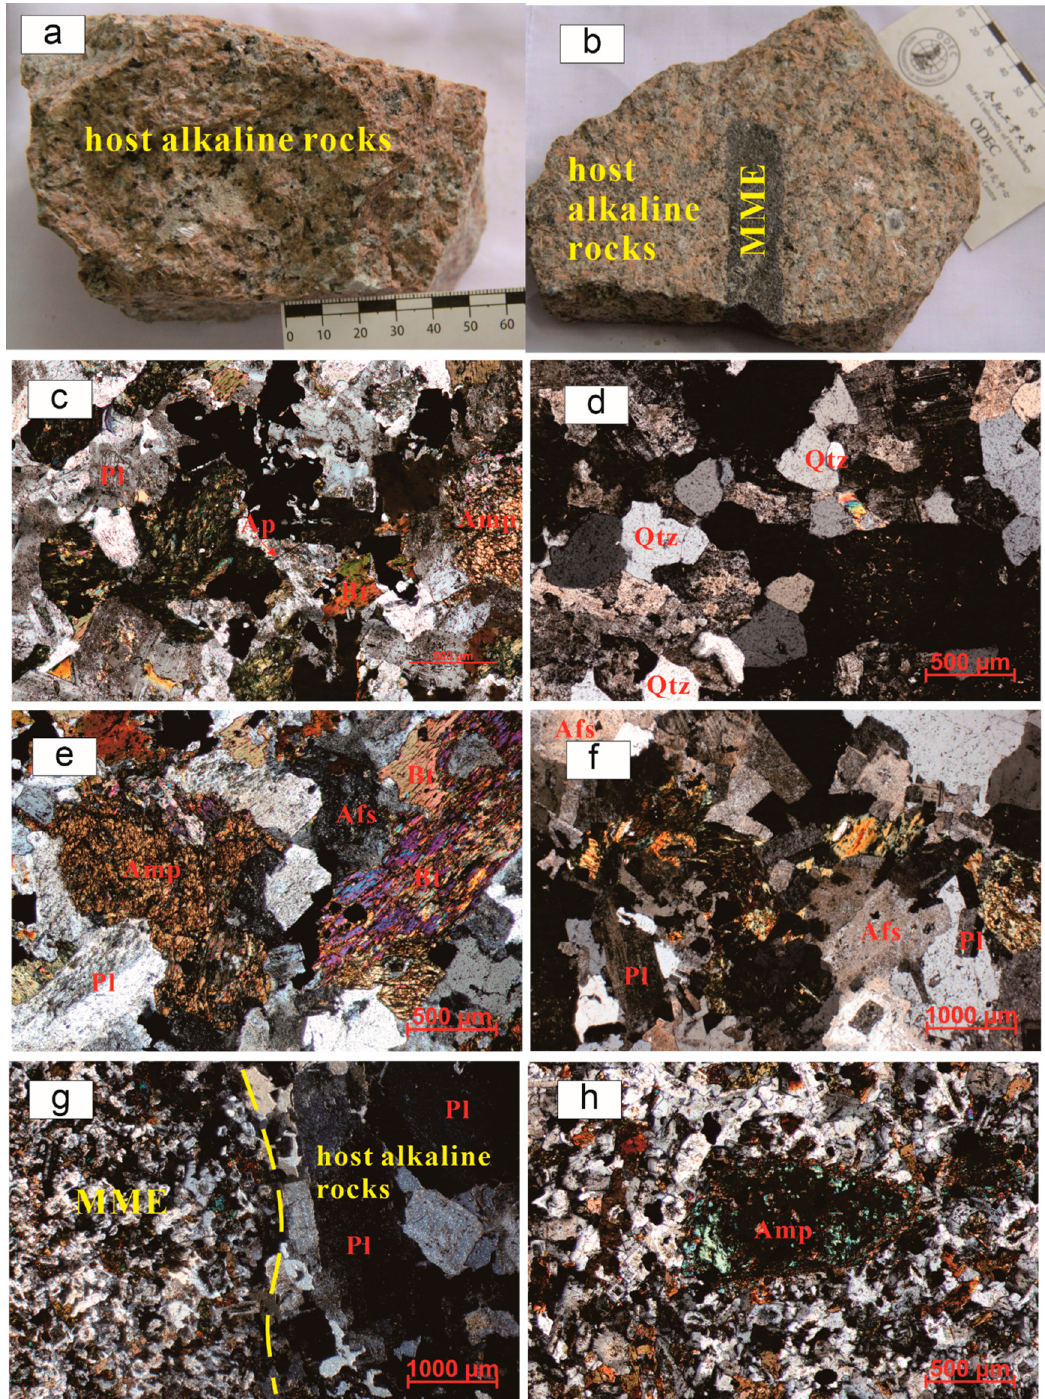
Figure 3. ( a , b ) Field photographs of quartz monzonite and MME (mafic microgranular enclave) in Muchen pluton; ( c – f ) are thin section photographs of the host quartz monzonite; ( g ) is the mineral assemblage between MME and host quartz monzonite; ( h ) is the minerals assemblage of MME. All the thin section photographs ( c , d ) are cross-polarised light. (Pl = plagioclase, Afs = alkali-feldspar, Qtz = quartz, Bt = biotite, Amp = amphibole, Ap = apatite).